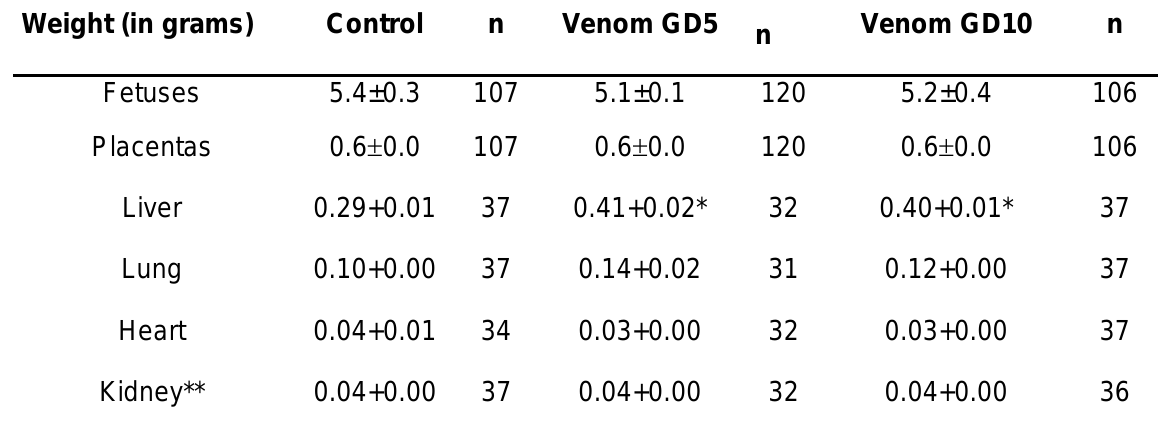
Table 2. Weight of fetuses, placentas and some internal organs of fetuses of dams treated with Tityus serrulatus venom, 3.0mg/kg, on the 5 th and on the 10 th gestation day